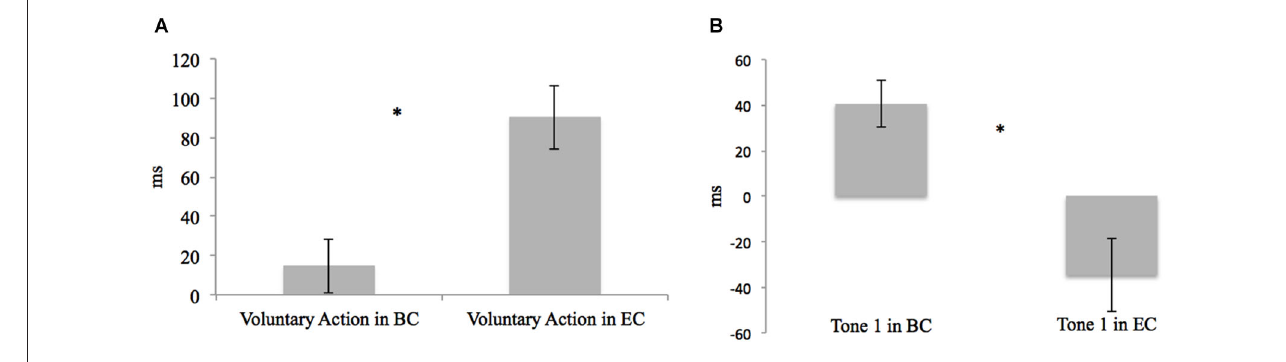
Differences in mJE of Tone 1 in BC vs. EC in the young adult group. Error bars represent SEM and * indicates the significantly difference between BC and EC ( p < 0.05). Here, participants perceived the onset time of the Tone 1 earlier when it was activated by the voluntary action (Tone 1 in EC), in comparison to the BC where only the tone was presented (Tone 1 in BC).